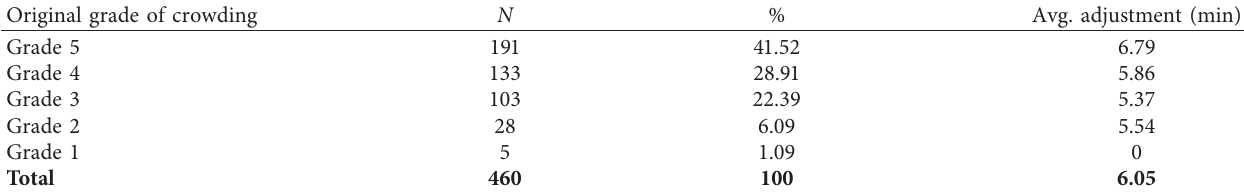
Table 7: The distribution of the grade of crowding of the most crowded part.